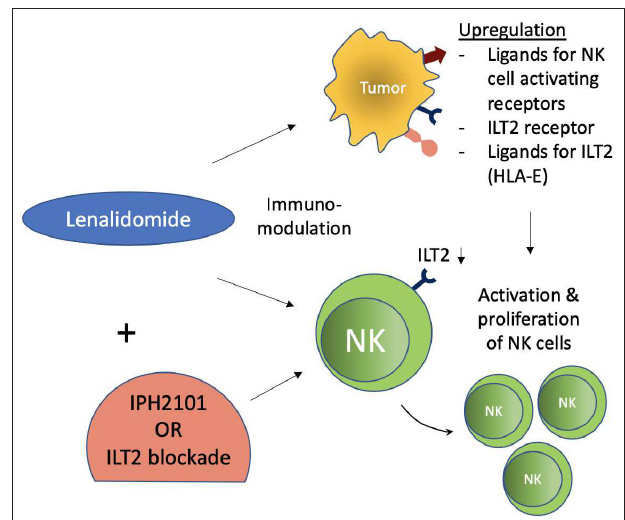
FIGURE 3 | Immunomodulatory effect of lenalidomide on NK cells. Lenalidomide upregulates ligands for NK cell-activating receptors in multiple myeloma and augments NK cell function. Lenalidomide also increases ILT2 expression on CLL and decreases it on NK cells, while its ligand (HLA-E) is reestablished on leukemic cells. These immunomodulatory effects of NK cells were associated with increased NK cell activation and proliferation. ILT2 blockade in this setting further potentiated NK cell